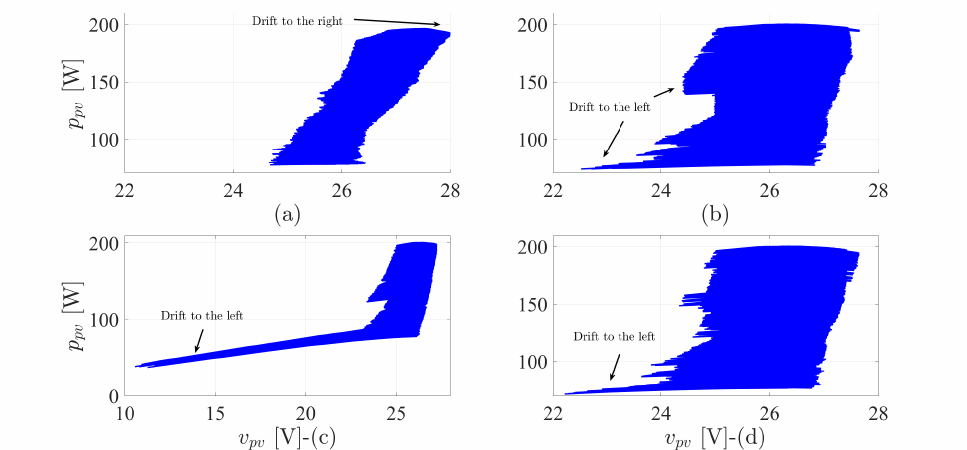
Figure 9. The power–voltage curves of the MPPT techniques under dynamic weather conditions: ( a ) Fixed switching MPPT-based digital observer. ( b ) MPPT-based FS-MPC. ( c ) The first proposed DMPPT technique-based direct P&O. ( d ) The second proposed DMPPT technique-based indirect P&O.